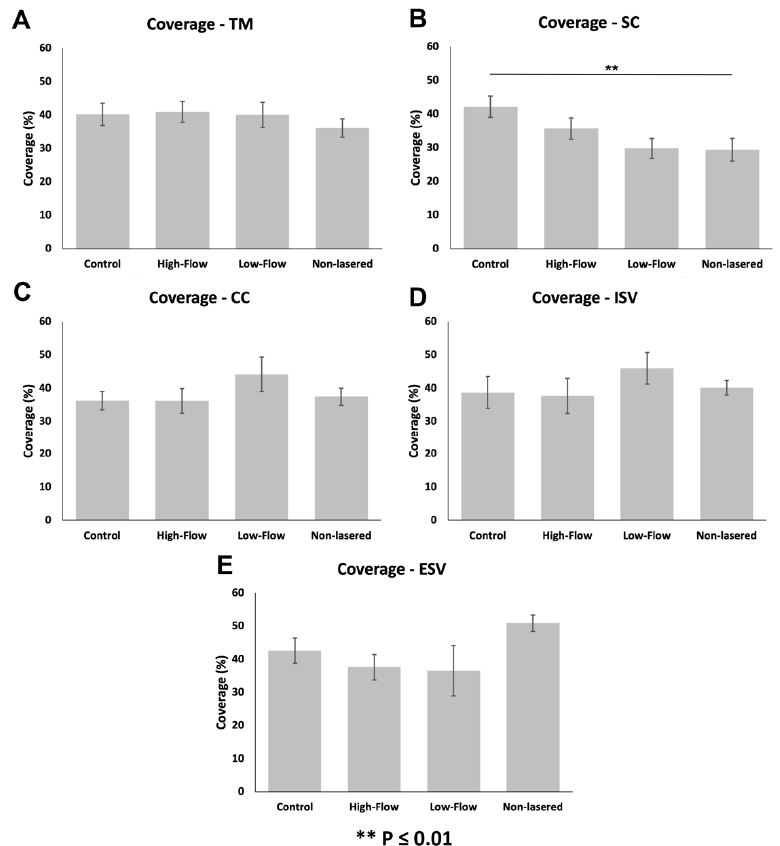
Figure 5. Glycocalyx coverage between different flow regions within various outflow pathway locations ( A ): Coverages between flow regions of the TM were not significantly different (ANOVA, F = 0.86, p = 0.47). ( B ): Coverage was significantly lower in SC of non-lasered regions (29.4 ± 3.4%; n = 43) than undetermined-flow regions of control eyes (42.2 ± 3.2%; n = 30; p ≤ 0.01). No significant difference in coverage in SC was noted between any other flow regions ( p > 0.05). ( C ): Coverages between flow regions of CCs were not significantly different (ANOVA, F = 1.01, p = 0.39). ( D ): Coverages between flow regions of ISVs were not significantly different (ANOVA, F = 0.91, p = 0.44). ( E ): Glycocalyx coverage across all different flow regions was significantly different in ESVs (ANOVA, F = 3.54, p = 0.02); however, pairwise comparisons revealed no significant difference in coverage. Error bars: SEM. ** p ≤ 0.01.